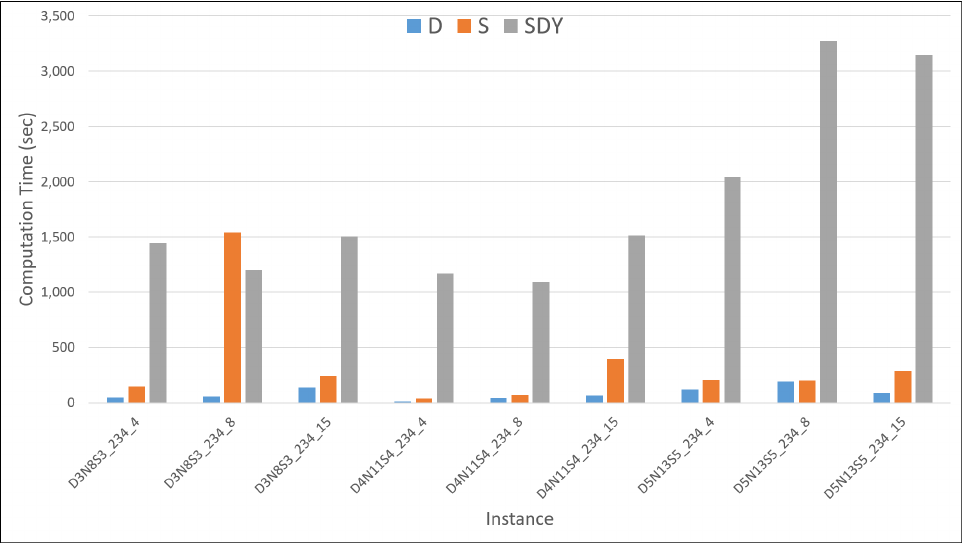
Figure A10. Computation Time for Maximum Road Capacity Setting ( 2,3,4 ) : Offline and Online Computation for all Instances based on Model